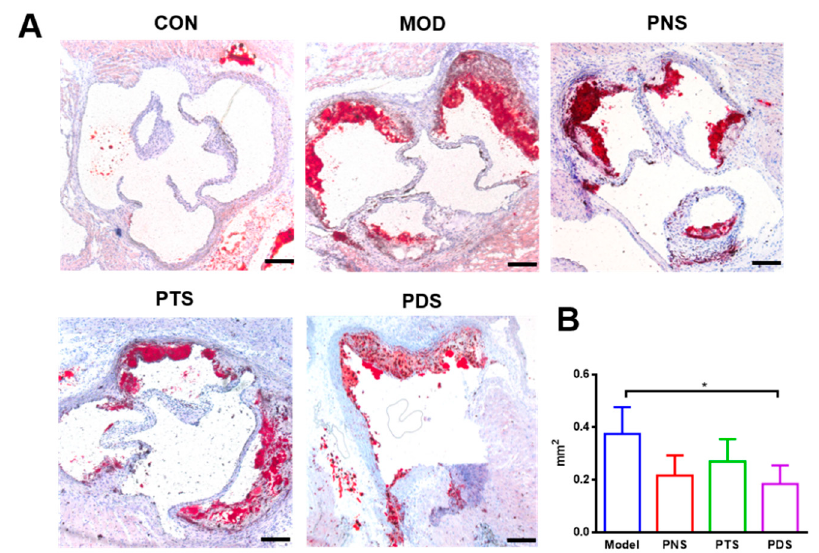
Figure 3. ( A ) Representative cross sections of the aortic sinus from all groups stained by Oil red O, and ( B ) the histogram of calculated lesion sizes (n = 3–4). Scale bar, 200 μ m. *, p < 0.05.